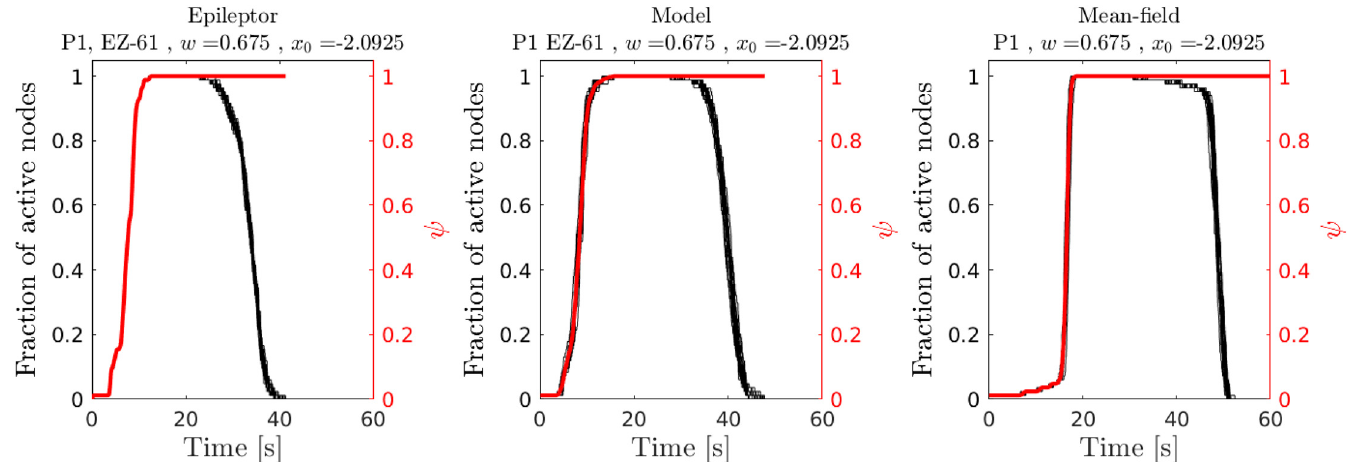
Fig 4. Temporal evolution of average spread size and fraction of active (seizing) nodes: Example for patient-specific network P1, EZ = 61. Each curve contains data from 20 different stochastic realizations. The right vertical axis (red) shows the mean normalized spread size ψ = h s / N i , where s is the number of nodes in the surround to which a seizure has spread to. The left panel corresponds to simulations of the patient-specific epileptor network model. The middle panel relates to the simulations of the proposed probabilistic model with the temporal Gillespie algorithm. The right panel shows simulations based on a derived mean-field dynamics (see below and Materials and methods, Mean-field dynamics). In this mean-field approximation, derived under the assumption of Erd ő s-Re´nyi random network connectivity, we used an average connectivity weight and an average interaction delay. For this figure, both were computed from the corresponding patient-specific network.